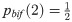
Average trajectories for the model with annealed cross links and several values of q.Each column corresponds to a different value of q, from left to right q = 2, 3, 4, 5. Results for the snobs are presented by the red dashed lines and for the followers by the solid green lines. Upper panels correspond to the probability of cross links p = pbif(q) − ϵ, middle panels to p = pbif(q) and bottom panels to p = pbif(q) + ϵ, where ϵ = 0.01. Note the difference in ranges on the vertical axis that corresponds to c—in the upper panels the range is much larger, i.e. [0, 1] than in the middle and bottom panels. Values of pbif, agree with the derived analytical Formula (18), i.e. pbif(2)=12 (first column), pbif(3)=23 (second column), pbif(4)=34 (third column), pbif(5)=45 (fourth column). The size of each clique is N = 104 for all panels.